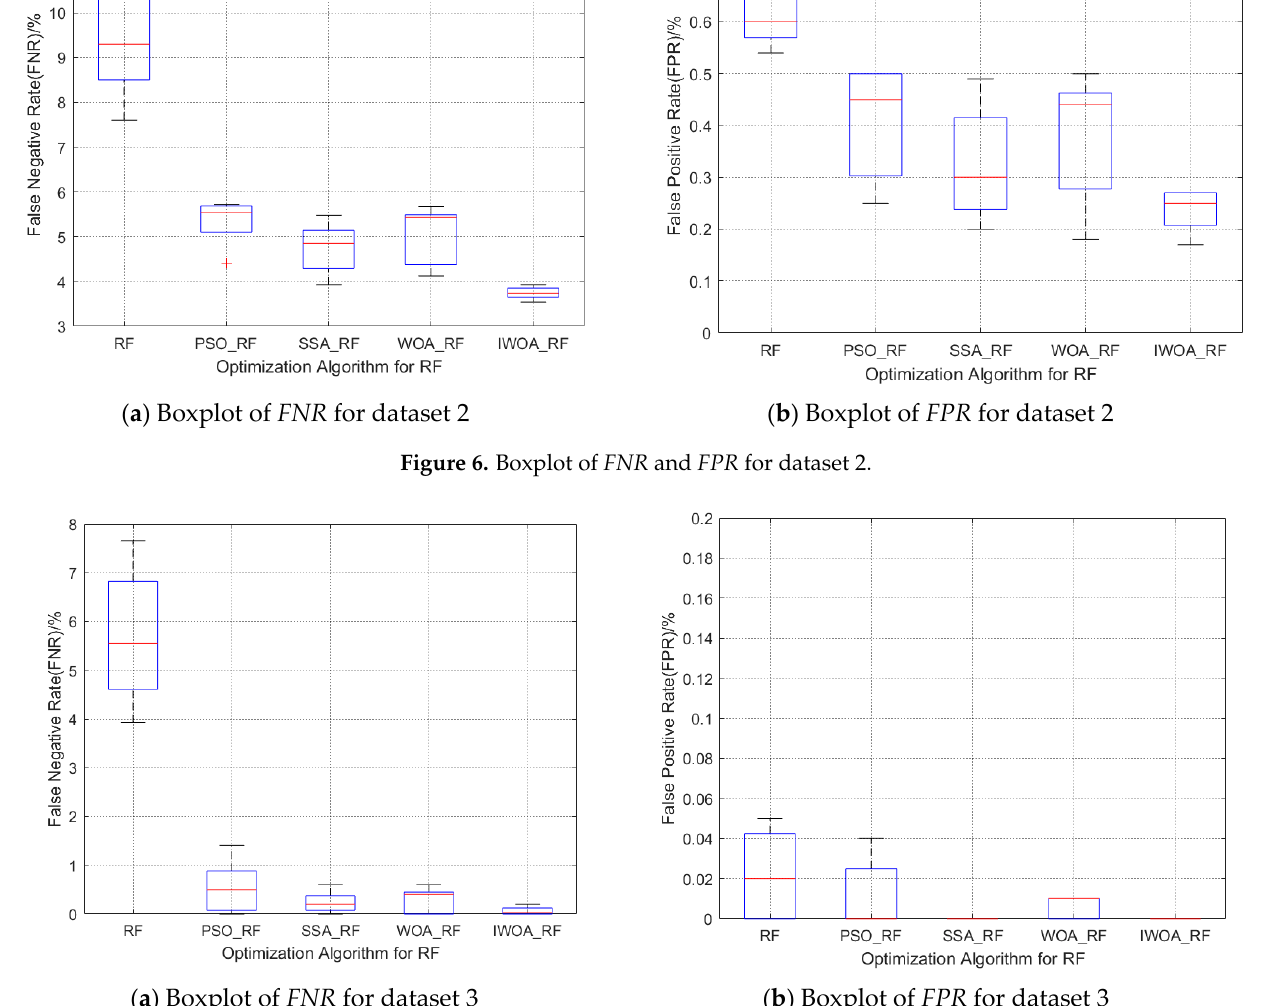
Figure 6. Boxplot of FNR and FPR for dataset 2.